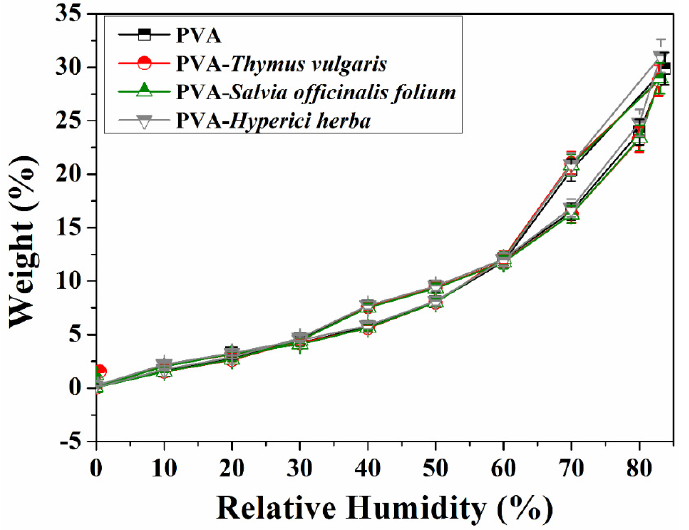
Figure 5. Isotherms of adsorption/dynamic desorption of water vapor of PVA fibers and PVA fibers–plant extract system.